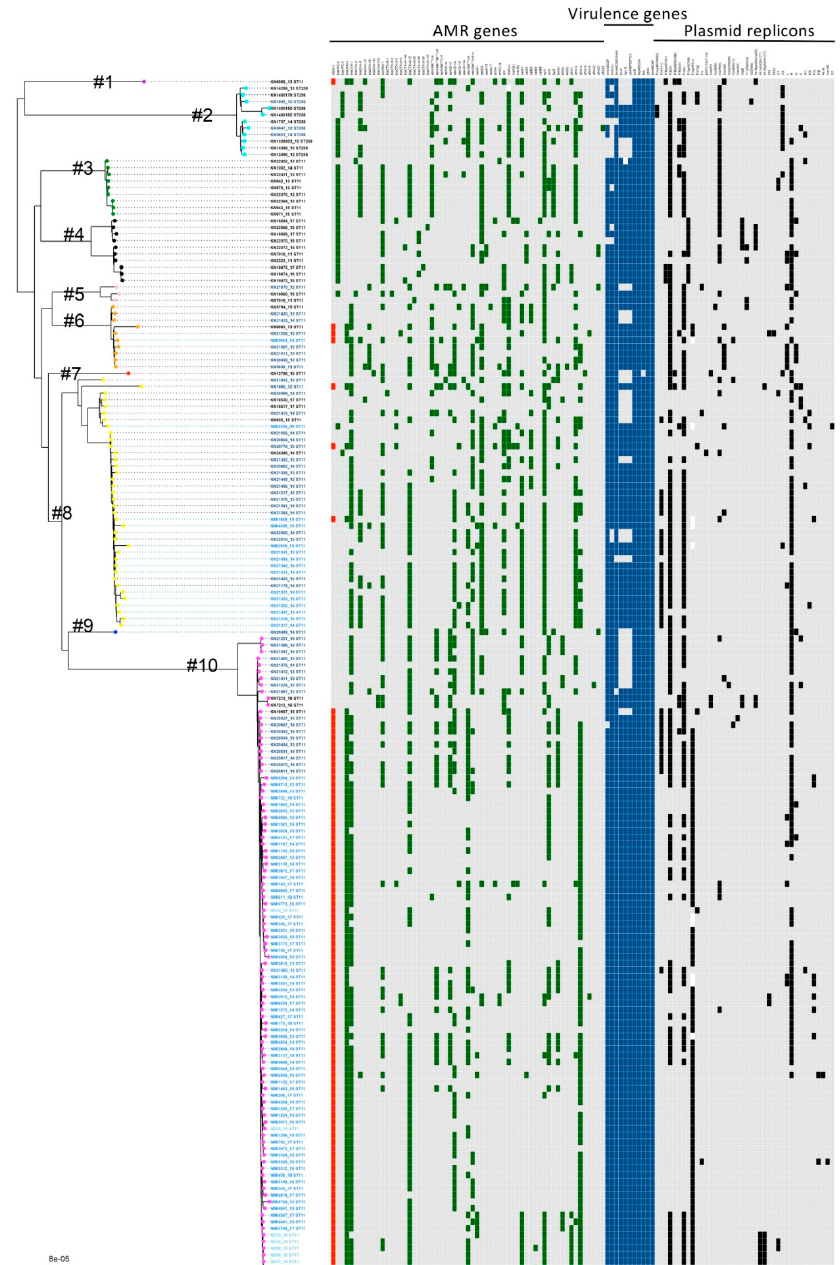
Figure 2. K. pneumoniae core-gene phylogenetic tree. A maximum likelihood phylogenetic tree was constructed using 4014 core genes with the genome sequences of 180 K. pneumoniae isolates. The cluster numbers (#1–#10) are labelled on the phylogenetic tree and the colour of the circle in the external node is linked to the cluster (purple—cluster no. 1, cyan—cluster no. 2, green—cluster no. 3, black—cluster no. 4, pink—cluster no. 5, orange—cluster no. 6, red—cluster no. 7, yellow—cluster no. 8, blue—cluster no. 9, magenta—cluster no. 10). The origin of the isolates is distinguished by font colours in the tree: light blue—isolates sequenced in this work; blue—from Poland; deep blue—from Europe; black—from other countries. The sequence type (ST) is indicated for each isolate, following the isolate name. Numbers after the isolate name correspond to original numbers of the study isolates or GenBank assembly numbers. In the heatmap, the presence of the bla NDM-1 gene is indicated by red (present) or gray (absent) and the presence/absence profile of the genotype for 60 genes encoding antimicrobial resistance (green—present, gray—absent), 11 genes encoding virulence determinants (blue—present, gray—absent), and 40 plasmid replicons is